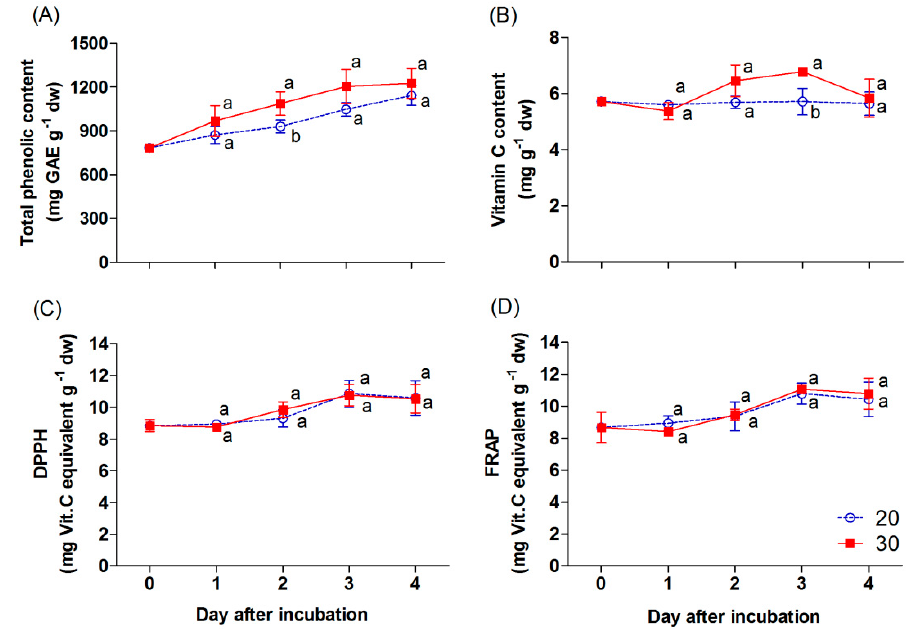
Figure 6. E ff ect of incubation temperatures at 20 and 30 ◦ C on total phenolic content ( A ), vitamin C content ( B ), and antioxidant capacity values; DPPH ( C ) and FRAP ( D ) of “Takanotsume” chili for 4 days. Values are means ± SD ( n = 3). Di ff erent letters indicate a significant di ff erence between temperatures on the same day of incubation ( p ≤ 0.05).